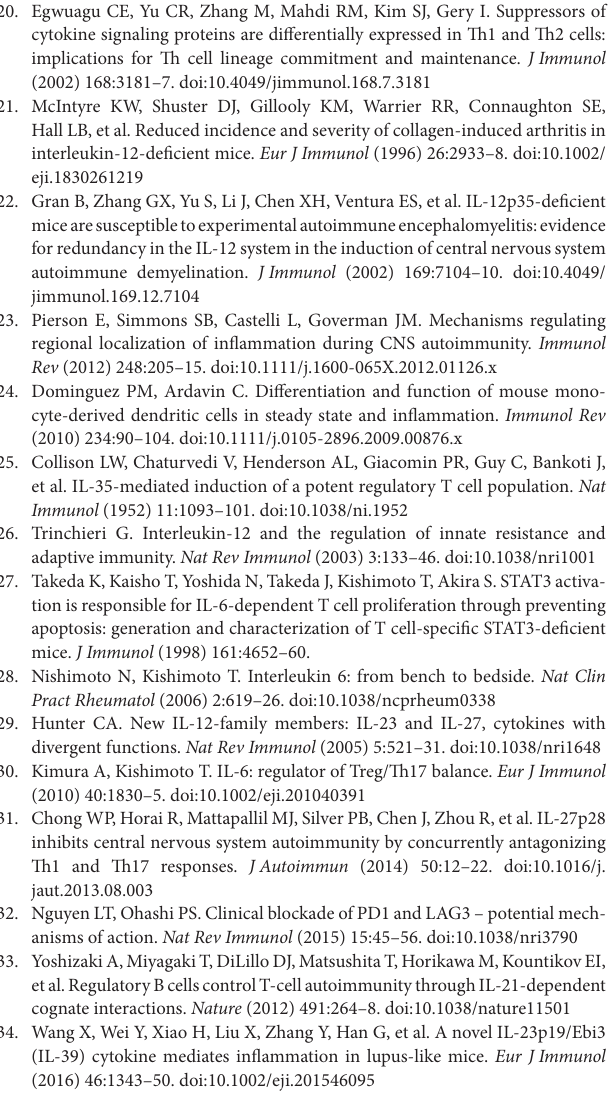
FigUre s1 | Schematic representation of the cDNA construct used to produce the recombinant IL-12p35 (p35) protein in insect cells. (a) HBM, honeybee melittin secretion signal; FLAG and HIS are tags used to facilitate the isolation and purification of the p35 protein. (B,c) Characterization of the p35 protein following two sequential purification cycles on fast performance liquid chromatography columns. (D) Western blot analysis of the purified p35